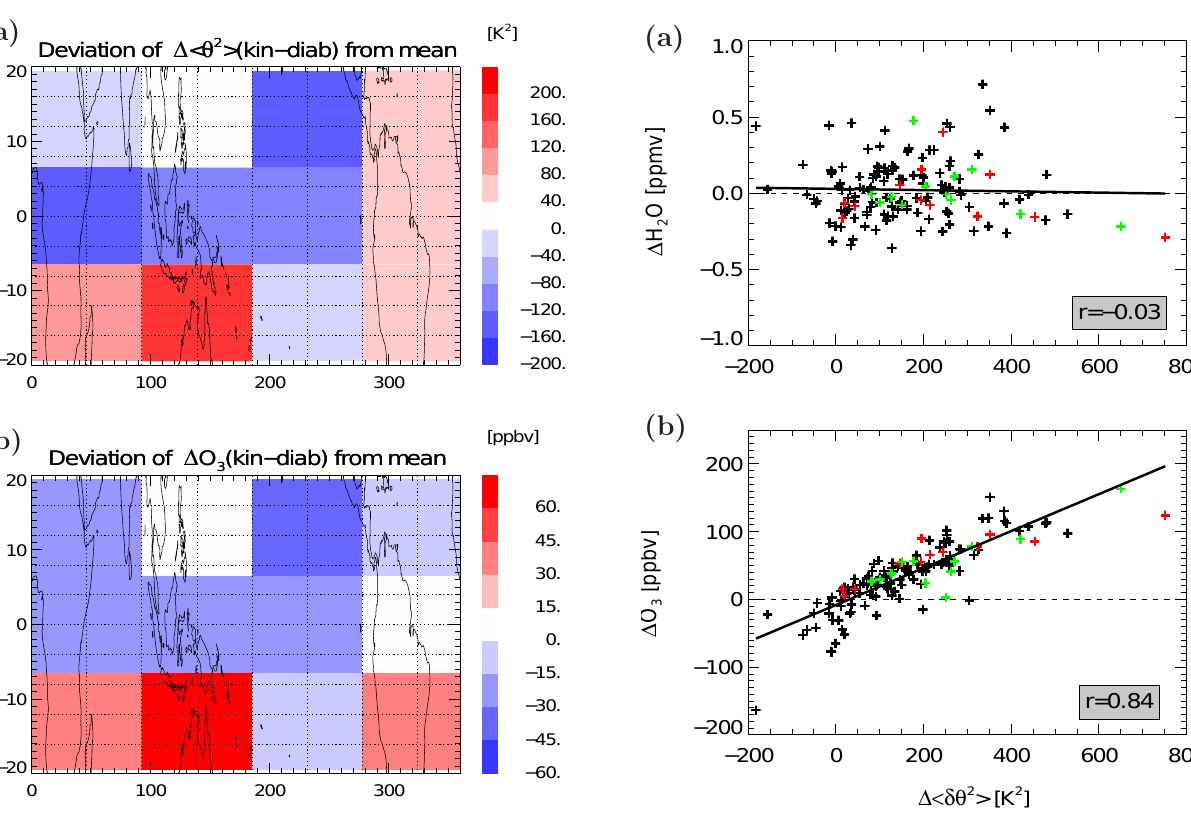
Fig. 7. (a) Correlation between difference in model predicted wa- ter vapour and difference in dispersion (quantified from potential temperature variance h δθ 2 i , see text), with difference denoting the difference between kinematic and diabatic backtrajectory calcula- tions, started in the tropics on 400K potential temperature once per month over the year 2002. Each symbol represents the wa- ter vapour and dispersion difference for one grid box of 13 ◦ × 90 ◦ latitude/longitude (compare Fig. 6). (b) As (a) but for ozone. Red/green data points in both panels refer to the grid box over Northern Australia and the maritime continent region (see Fig. 6). The correlation coefficient r is shown in each